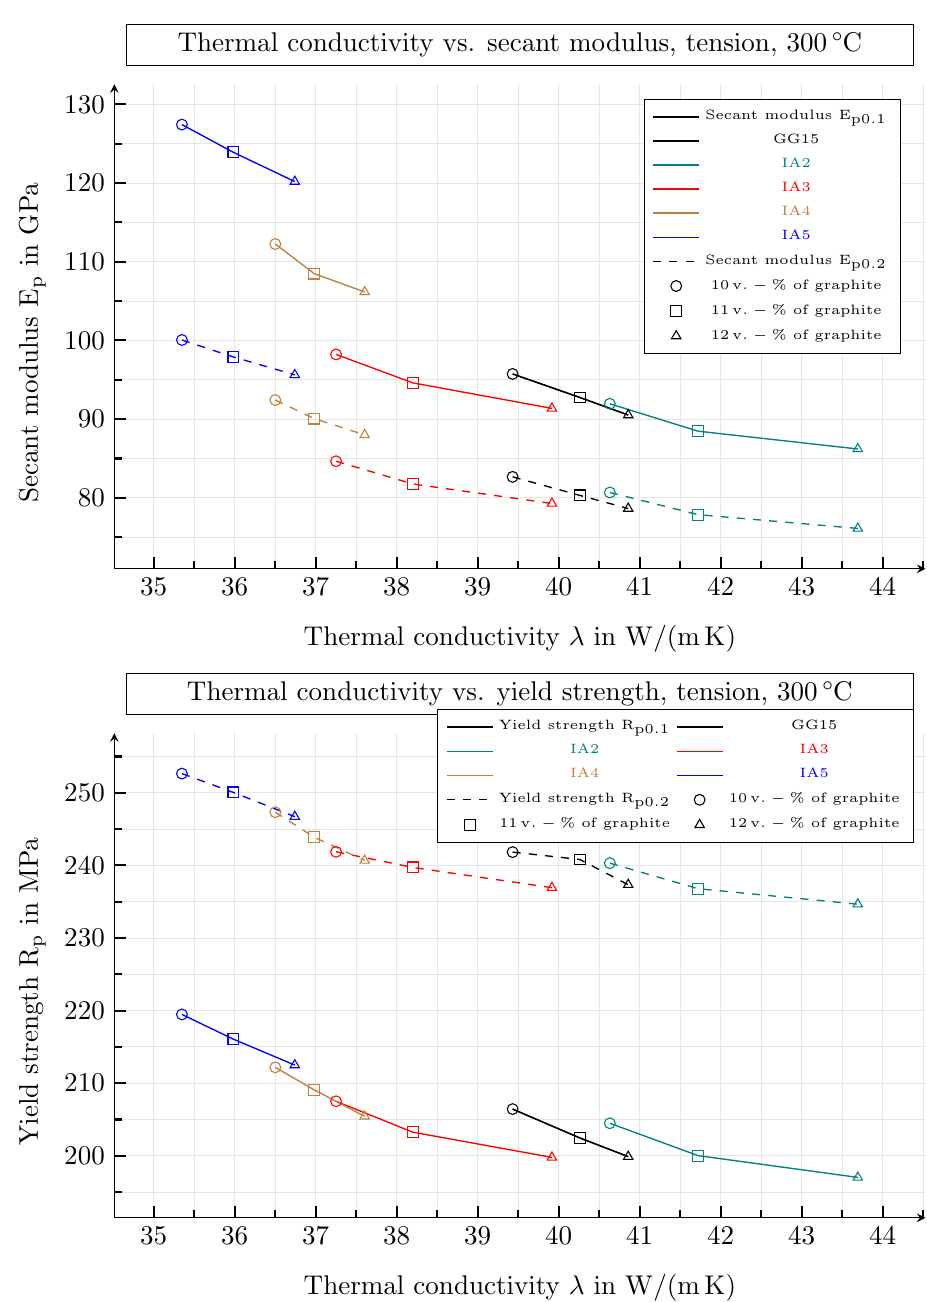
Figure 32. Secand moduli and yield strengths vs. thermal conductivities of all graphite classes with graphite flake volume fractions of 10, 11 and 12v. % at a temperature of θ = 300°C. The properties − capture tensile load for strains of ε = 0.1% and ε =